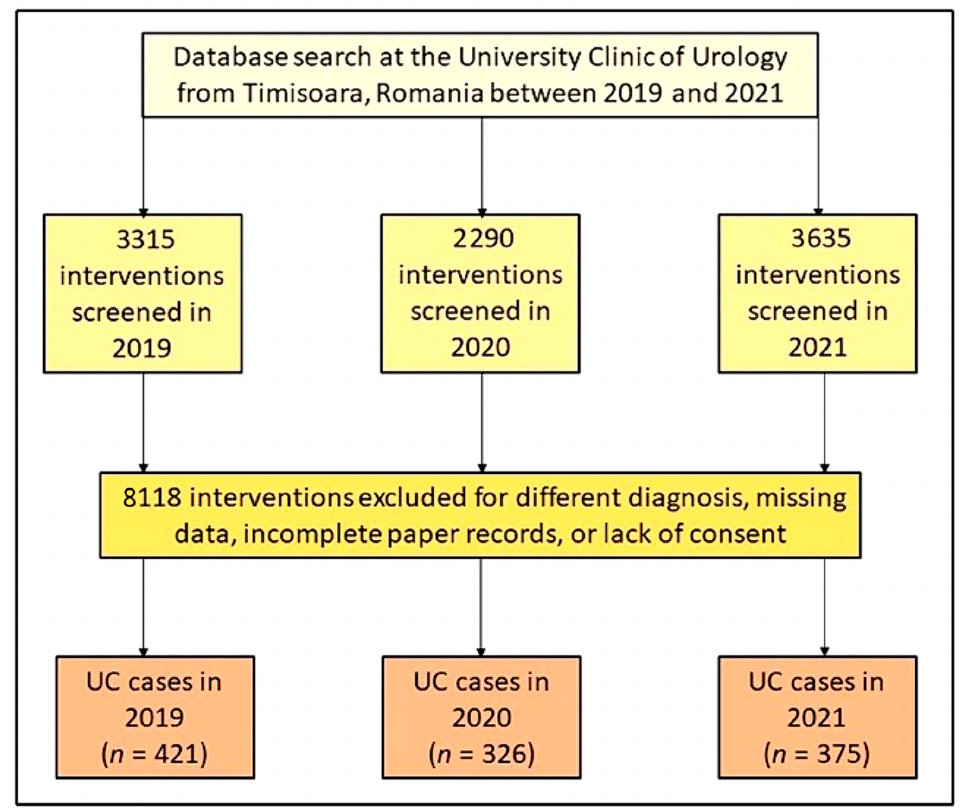
Figure 1. Diagram depicting the inclusion of patients who had surgery for urothelial carcinoma (UC) during the three-year data